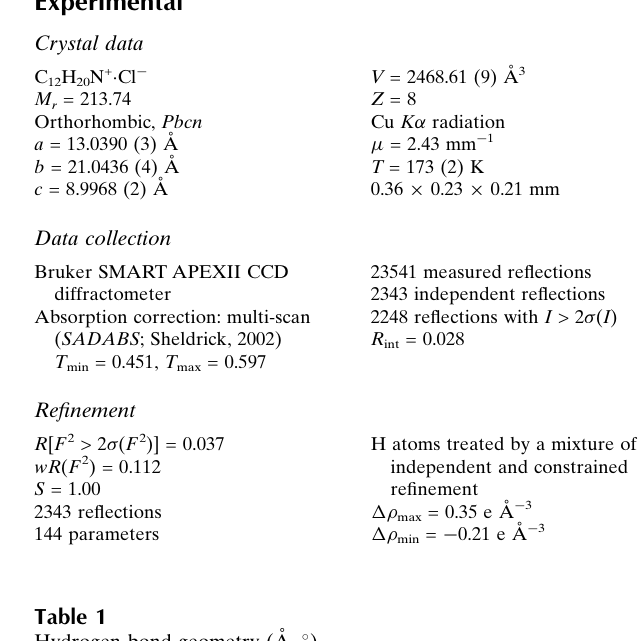
Hydrogen-bond geometry (A˚ , (cid:4)